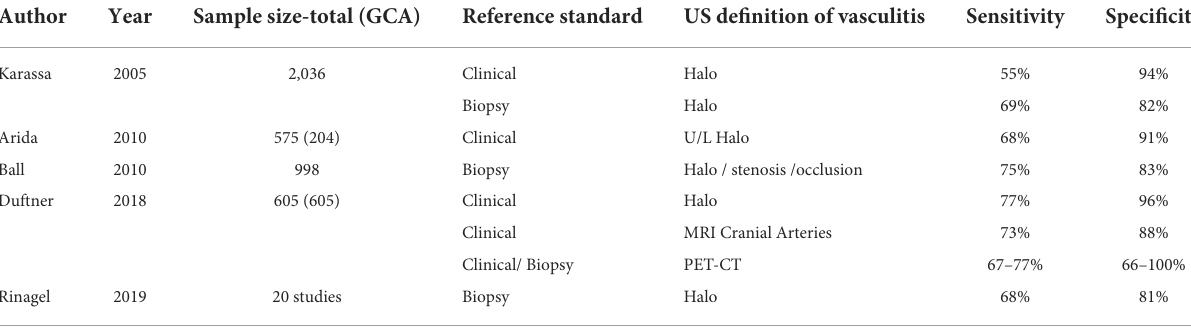
TABLE 2 Meta-analyses and systematic reviews relating to